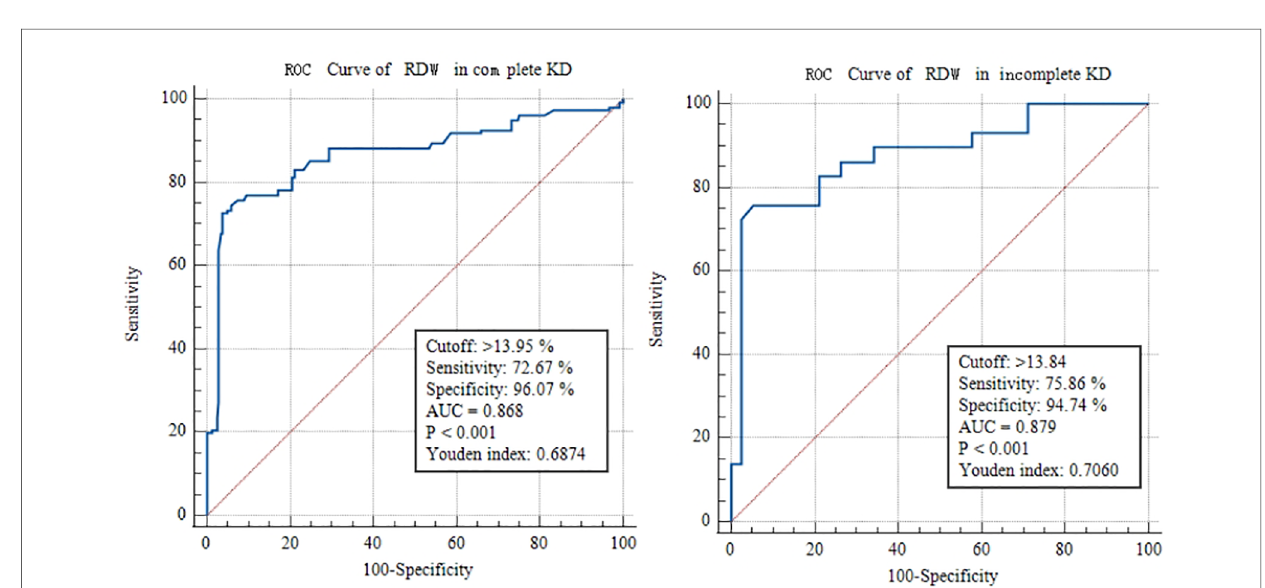
FIGURE 3 ROC curve analysis of RDW to predict CALs in complete and incomplete KD